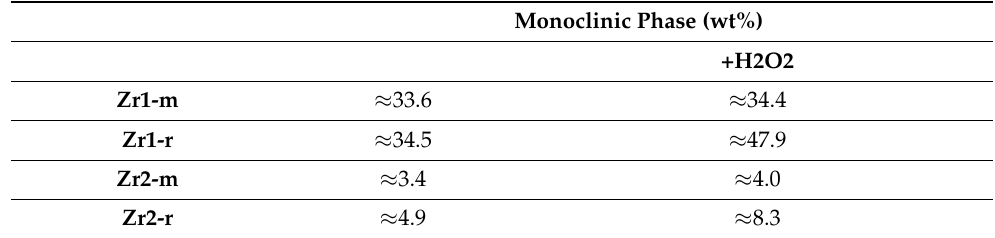
Table 2. Percentages of the monoclinic phase of all four surfaces before and after H 2 O 2